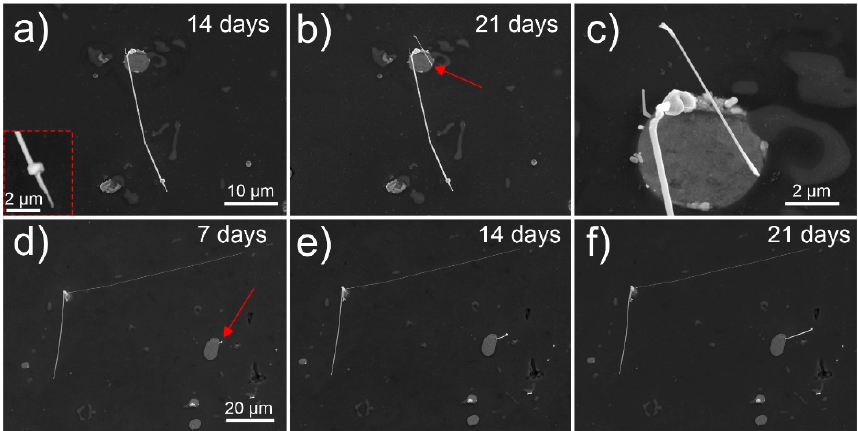
Figure 4. Scanning electron microscopy micrographs (obtained with secondary electron imaging) of Pb whisker growth with ( a – c ) spontaneous growth and with ( d – f ) continuous growth. Image ( c ) is a magnified view of the region of Bi-Mg-Pb pool in image ( b ) with the same timestamp of image ( b ). The red arrows indicate the positions of interest for the observation of whisker growth. The timestamp denotes the time from the final polishing of the surface.